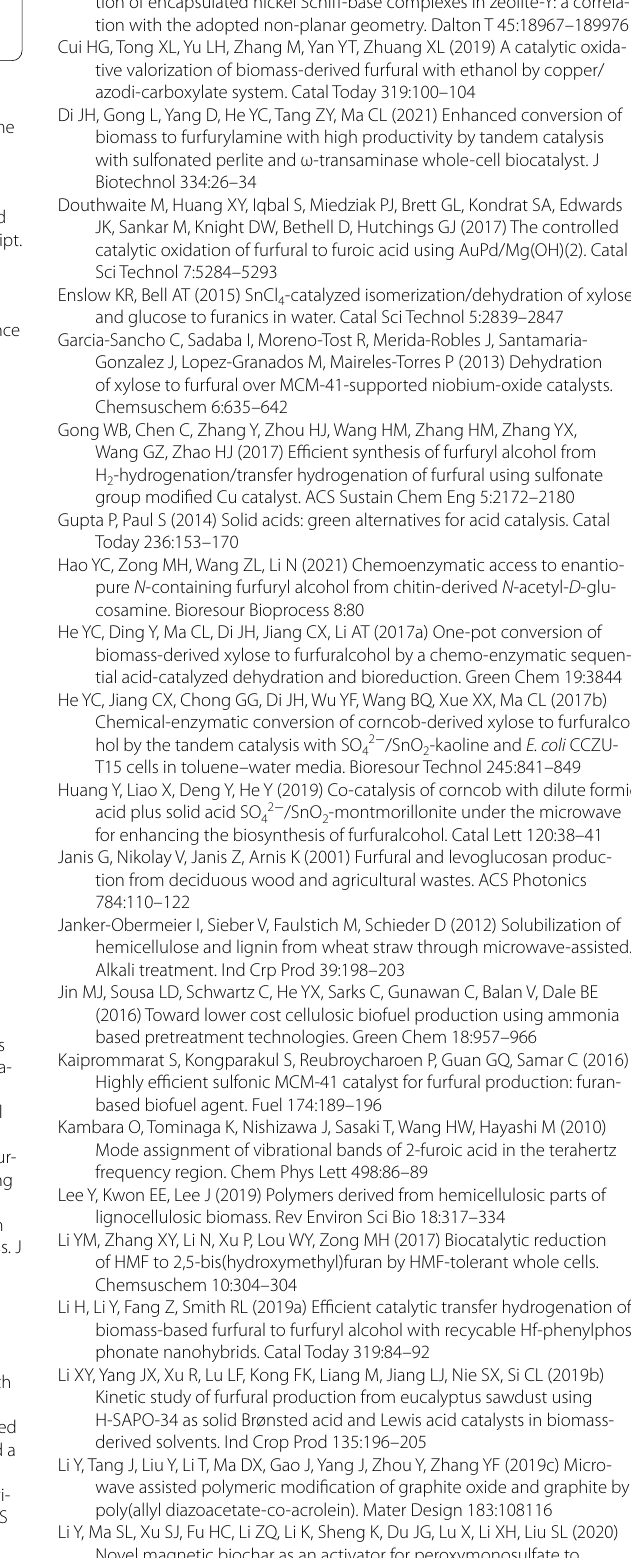
Additional file 1: Figure S1. FTIR image of GP and Sn‑GP ( A ) and XRD images of GP and Sn‑GP ( B ). Table S1. Surface and pore characteristics of GP and